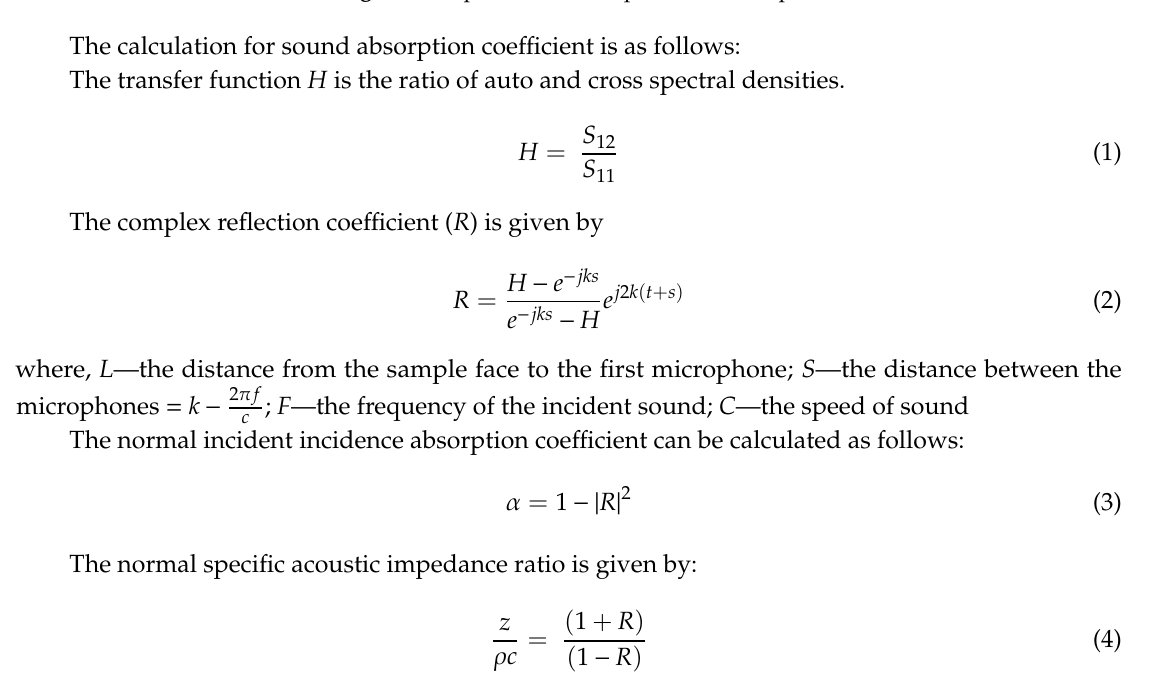
Figure 3. Impedance tube experimental